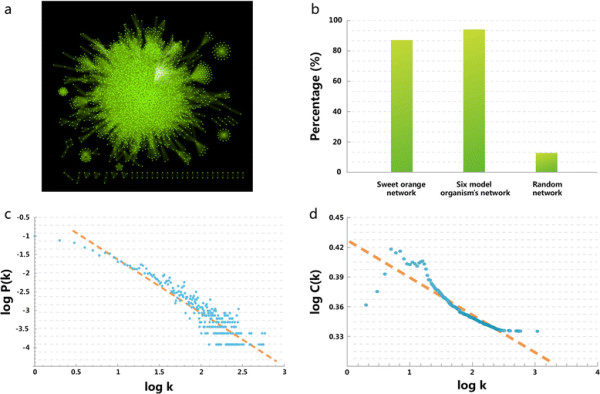
Overview and general properties of CitrusNet. (a) Overview of CitrusNet. (b) Ratio of KNN-verified PPIs in CitrusNet, six model organisms, and a random network. (c) Degree distribution of CitrusNet. (d) Cluster coefficient distribution of CitrusNet.